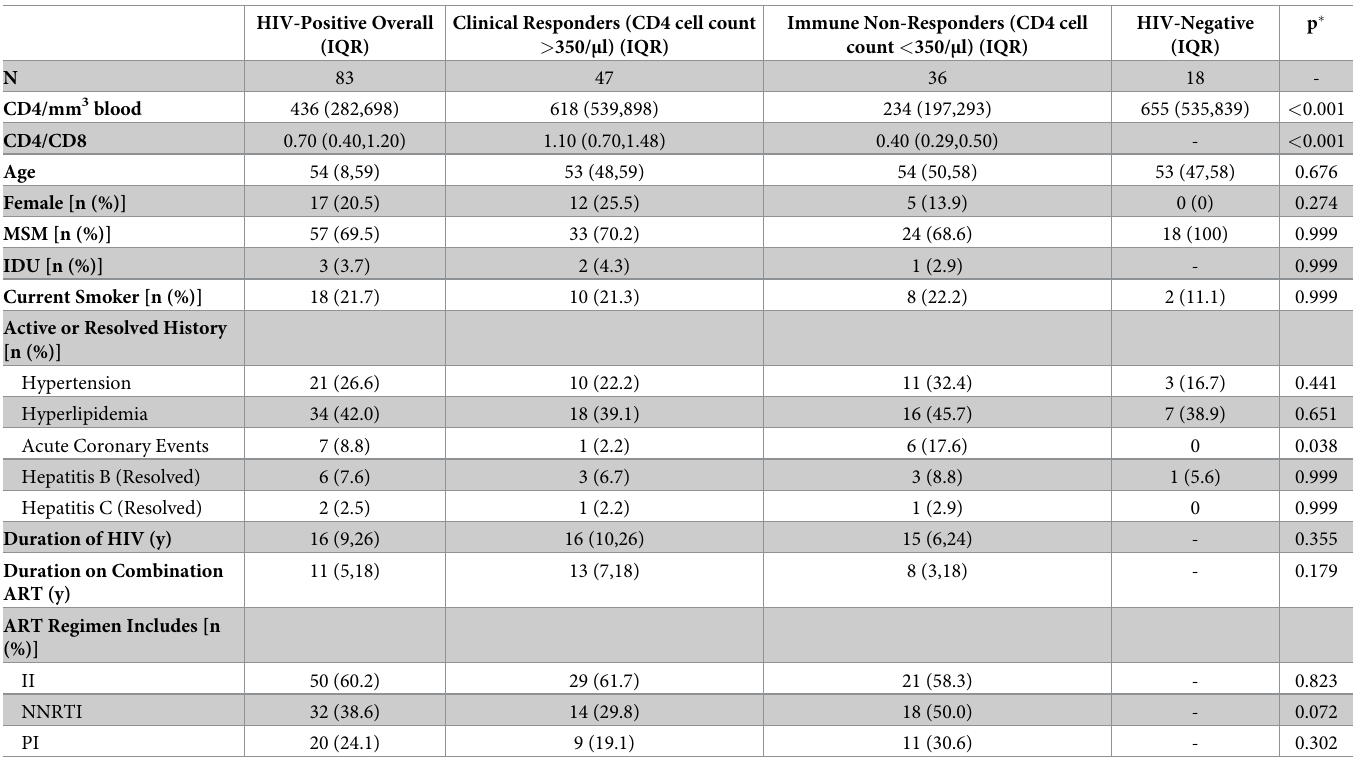
Table 1. Participant